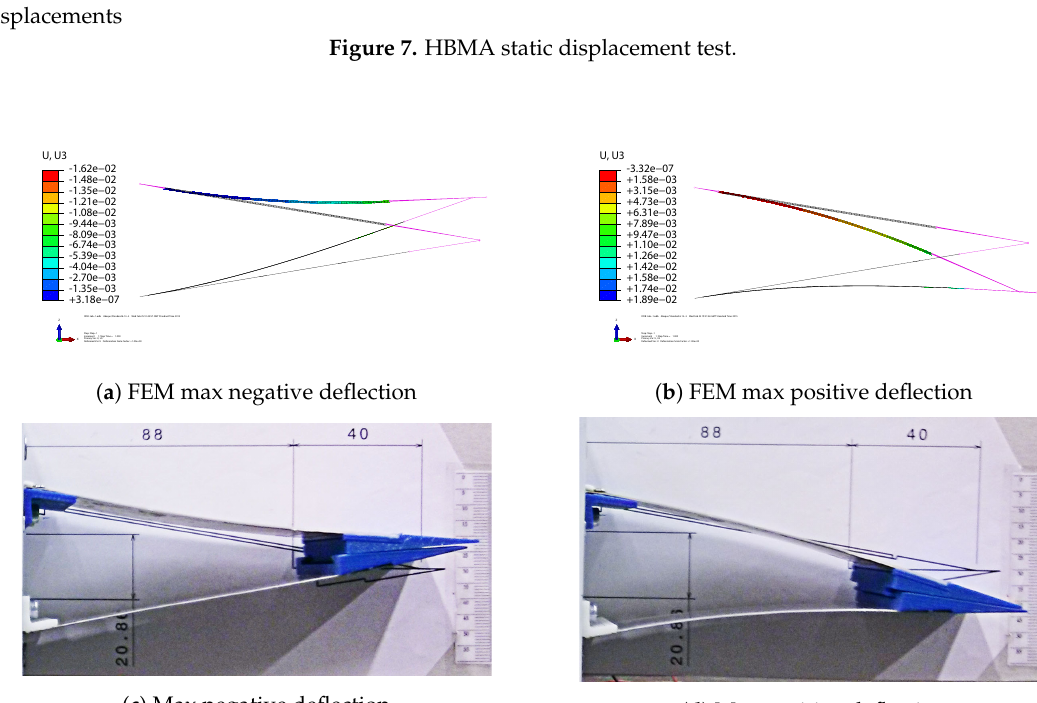
Figure 8. HBMA static